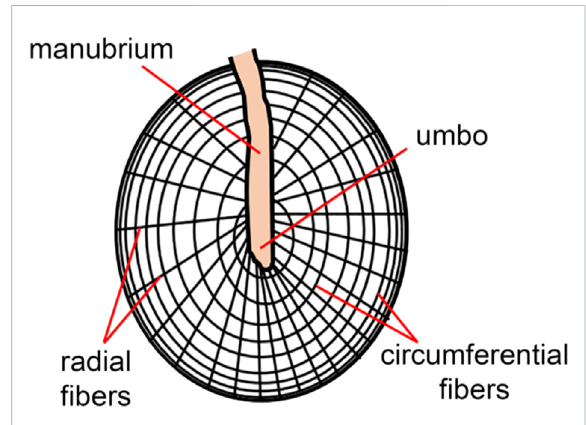
FIGURE 3 Theskinoftheearcanalformstheouterlayeroftheeardrum, and themucouslining ofthemiddle ear cleft formstheinner layer. The ultrastructure of the tympanic membrane shows